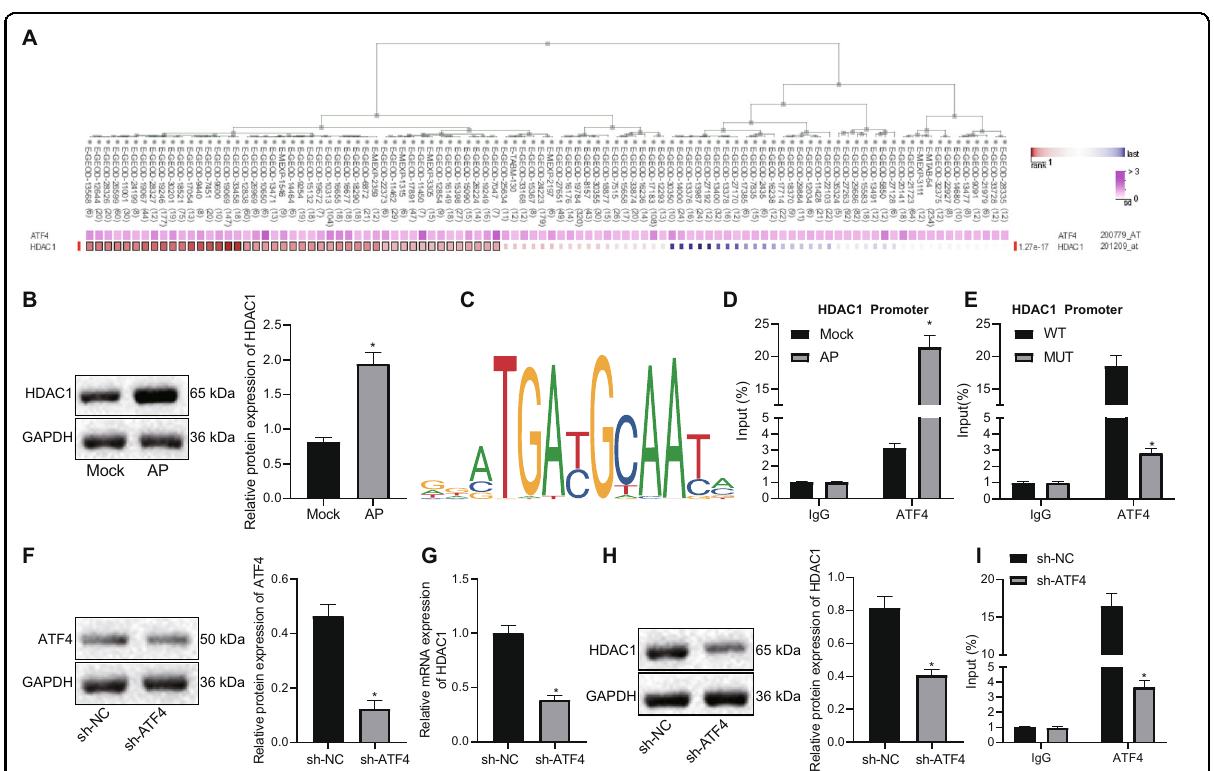
Fig. 3 ATF4 binds to the HDAC1 promoter and upregulates its expression in AP. A Co-expression analysis with MEM to determine the co- expression relationship between ATF4 and HDAC1 ( p = 1.27e − 17). B Expression of HDAC1 in an AP animal model detected by western blot analysis. C The binding site of ATF4 and HDAC1 promoter obtained through JASPAR. D ChIP was used to detect the enrichment of ATF4 in the HDAC1 promoter. E After mutation, ChIP was applied to detect the enrichment of ATF4 in the HDAC1 promoter. F Western blot analysis was used to detect the ATF4 expression in each group. G RT-qPCR was applied to detect the expression of HDAC1. H Western blot analysis was applied to detect the expression of HDAC1. I ChIP was used to detect the enrichment of ATF4 in the HDAC1 promoter. * p < 0.05 compared with the Mock, WT or sh-NC group. The comparison of the measurement data (mean standard±deviation) between two groups were tested by independent sample t